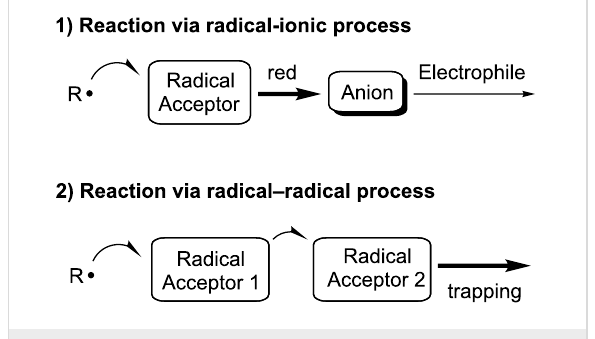
acid mediated cyclization approach for cascade bond-forming